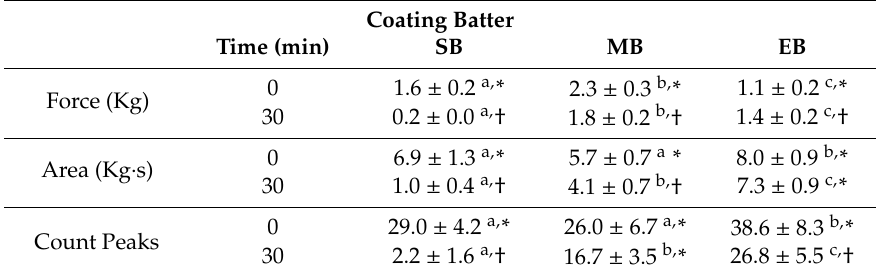
Table 4. Results of the texture analysis after instrumental analysis of samples with di ff erent coating